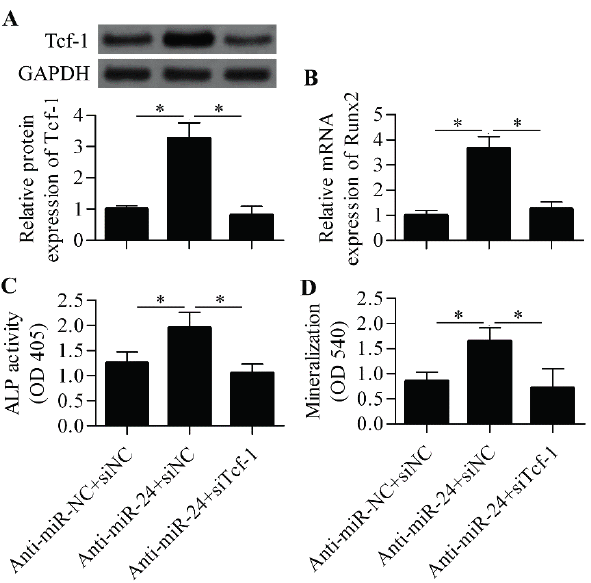
Figure 6. Tcf-1 knockdown abrogated the effect of anti-miR-24 on osteoblast differentiation. ( A ) Western blot analysis of Tcf-1 protein expression in anti-miR-24 transfected MC3T3-E1 cells in the presence with Tcf-1 siRNA. Anti-miR-NC and siNC were used as the control; ( B ) RT-qPCR analysis of Runx2 mRNA expression in the different groups; ( C ) ALP activity was detected by an ALP activity assay in the different groups after seven days of osteogenic differentiation; ( D ) Mineralization was assessed using Alizarin red S staining at day 7. N = 3, * p <